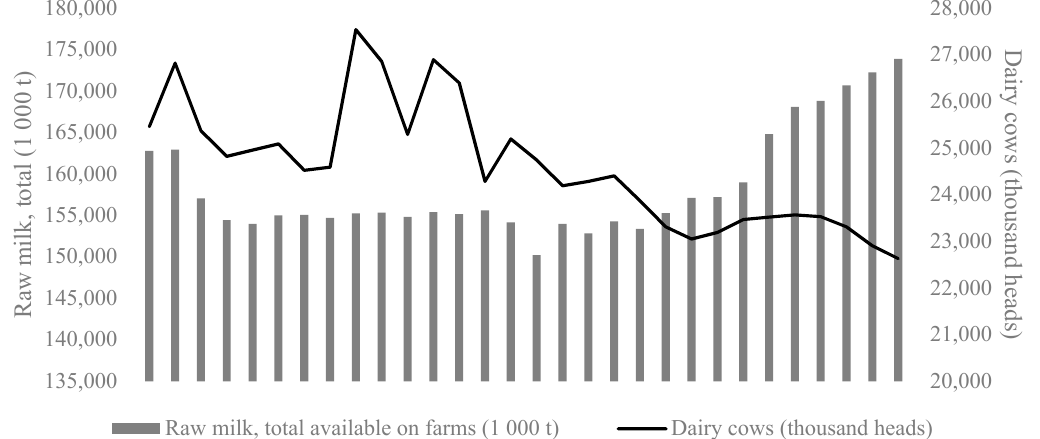
Figure 1. Development of the total production of raw milk and number of dairy cows in the EU. Source: Eurostat. Note: Non-available data was replaced by means of valid surrounding values.